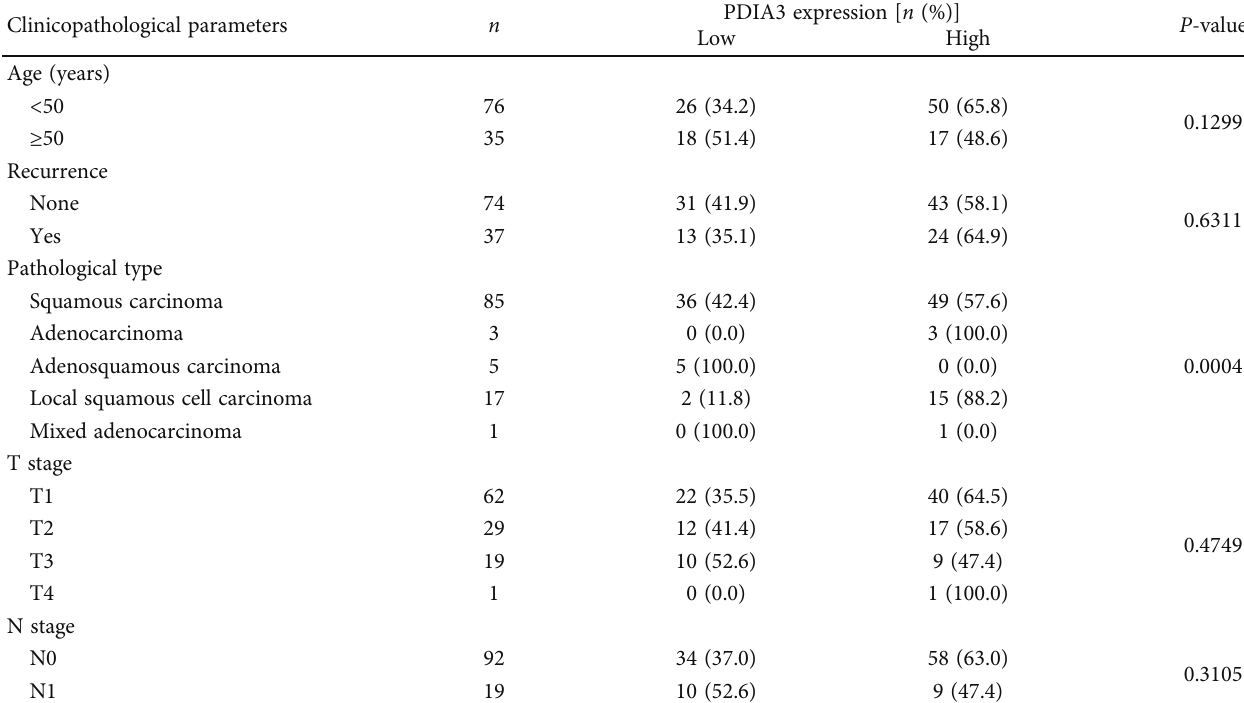
Table 2: Relationship between PDIA3 protein expression and clinicopathological characteristics of cervical cancer [ n (%)]. Clinicopathological